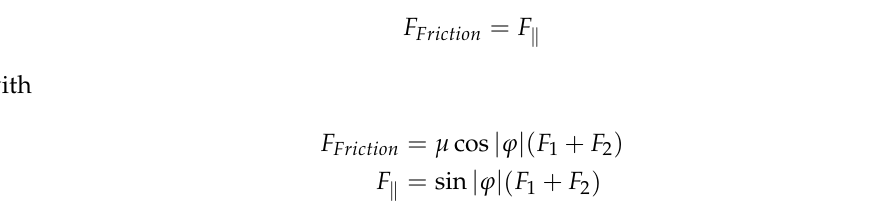
Figure 13. Definition sketch of the acting forces on a log with eccentricity e and yaw ϕ . Equilibrium of forces. The equilibrium of forces is set up at the contact point between the log and the pier. At this point, F Friction must be equal to (or greater than) F (cid:107) to hold the log at the